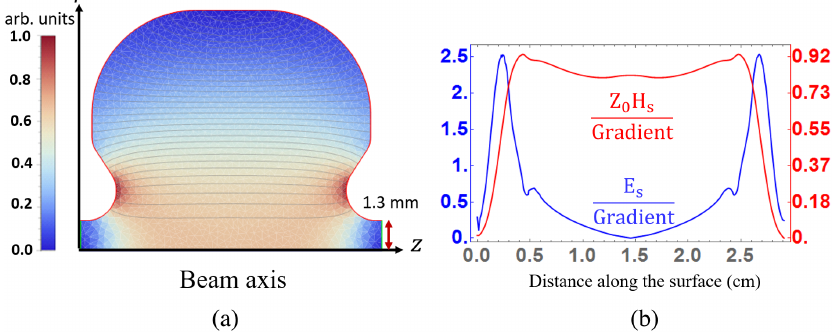
FIG. 5. (a) The optimized cell design and electric field profile plot. (b) A plot of the surface electric and magnetic fields for the optimized cell design for X-band linac with iris diameter of 2.6 mm.